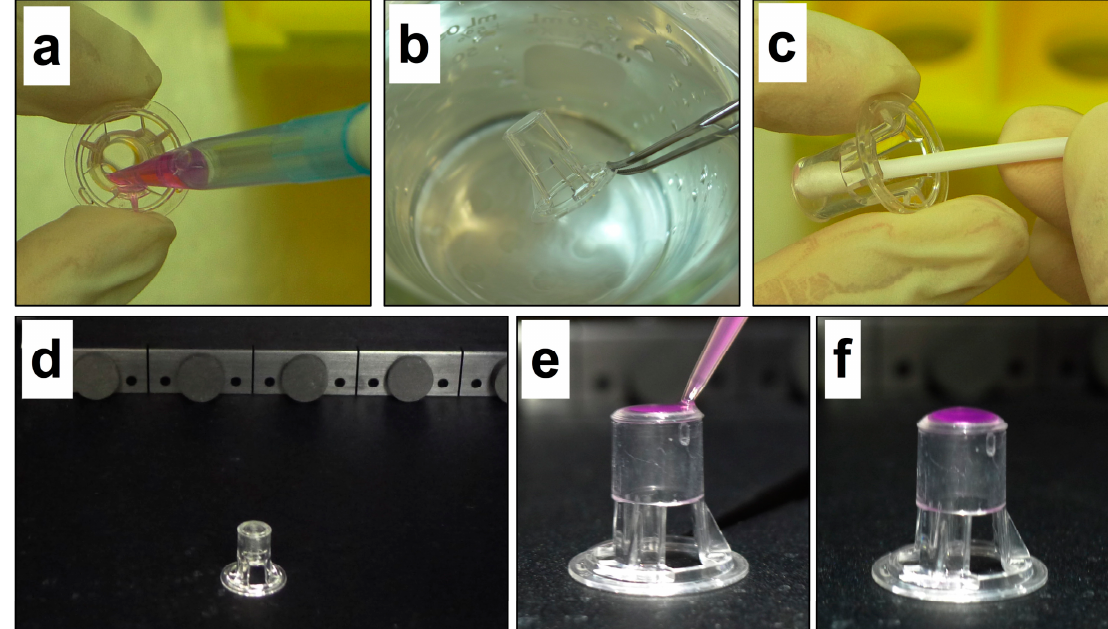
Figure 2. The processing steps of the bioluminescence migration assay. ( a ) Removal of nonmigrated cells and medium from the interior of the transwell. ( b ) Washing transwell in phosphate buffered saline (PBS). ( c ) Removal of nonmigrated cells and residual moisture from the interior of the transwell using a cotton swab. ( d ) Transwells are placed in the imaging chamber of the IVIS ® Spectrum in an inverted position and ( e ) 40 μ L of D-luciferin solution gently pipetted onto the exterior membrane surface. ( f ) Transwell is ready for bioluminescence imaging.